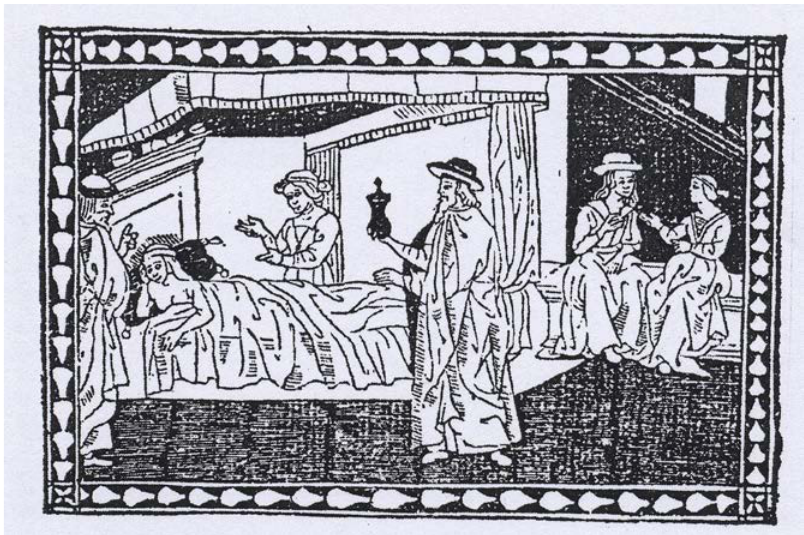
Figure 28 – Castellano Castellani, Rappresentazione di San Tommaso apostolo , Firenze, alla Badia, 1561, f. b4r (BNCF, Pal. E.6.5.1.V.22). By permission of Ministero per i beni e le attività culturali / Biblioteca Nazionale Centrale. Firenze